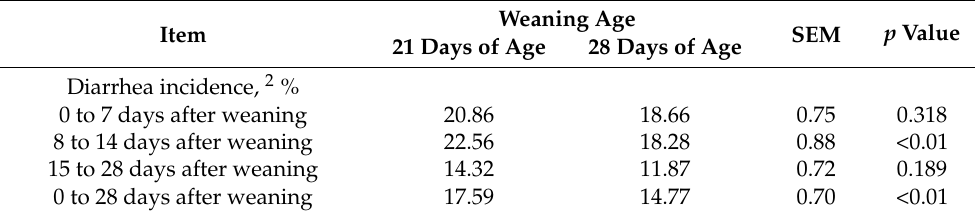
Table 3. Effect of weaning age on diarrhea incidence of weaned pigs 1 .